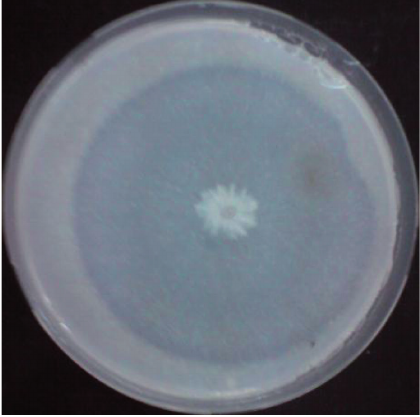
F 2: Plate showing PHB clearance by F. solani om.